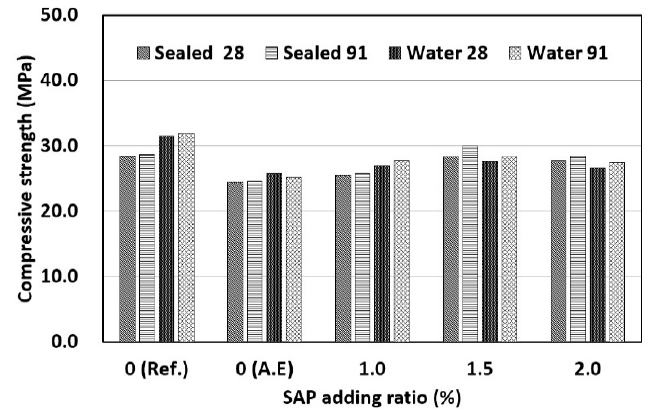
Figure 9. Results of compressive strength (W/C 50%).